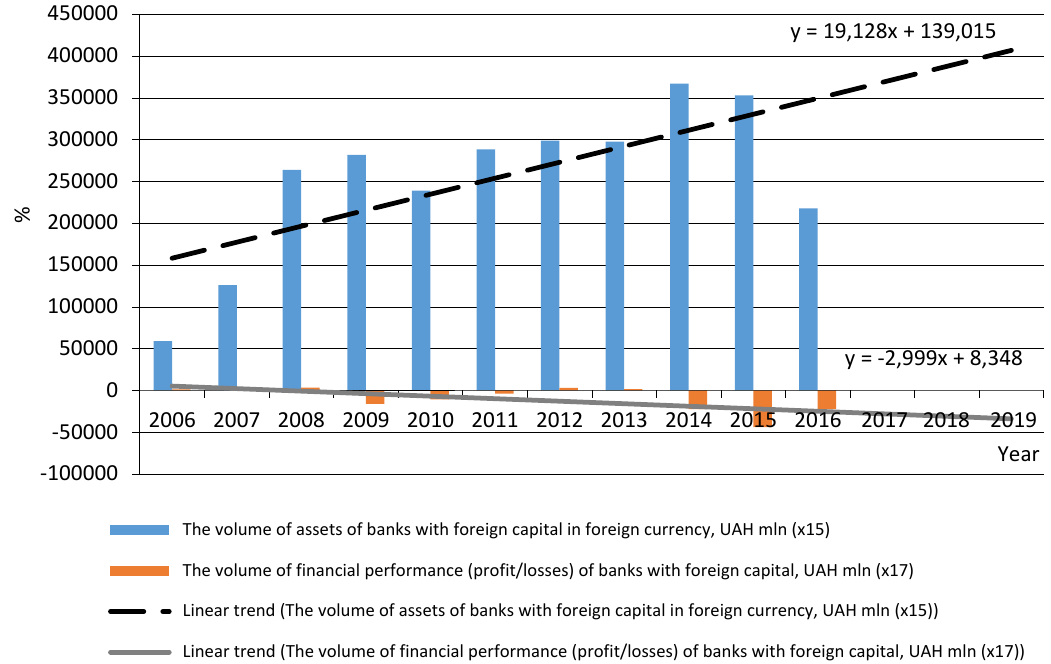
Figure 4. Trend analysis of foreign banks assets and financial performances via construction of diagram reflecting the linear